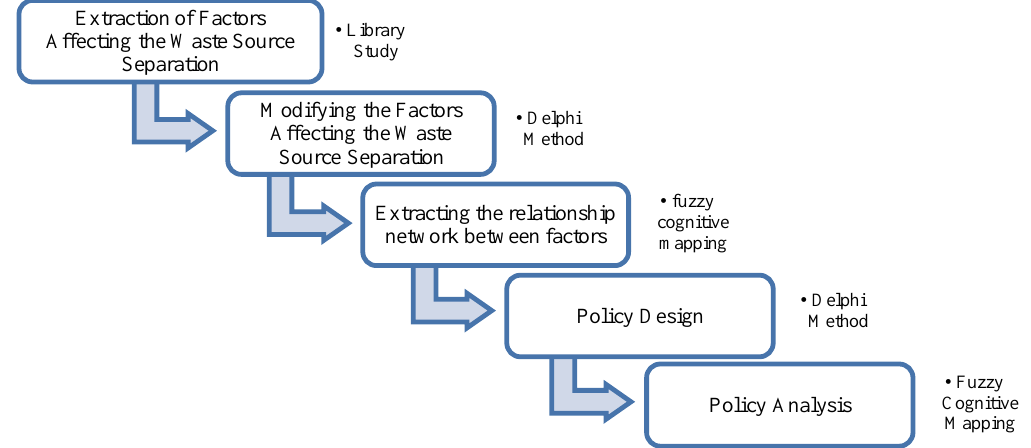
Figure 1 . Font Research method